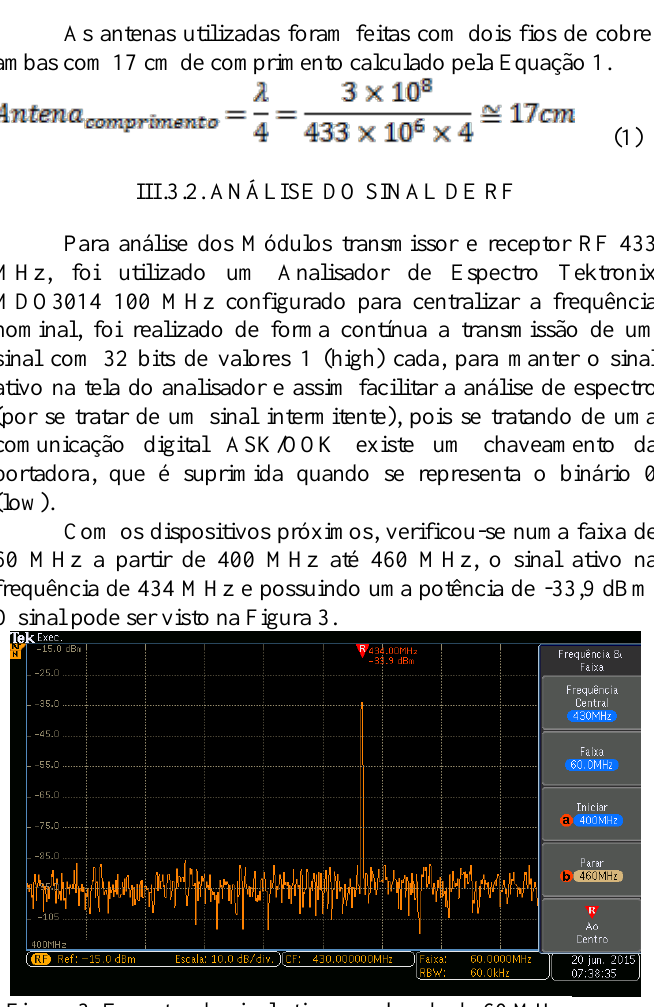
Figura 3: Espectro do sinal ativo com banda de 60 MHz. Fonte: Autores,